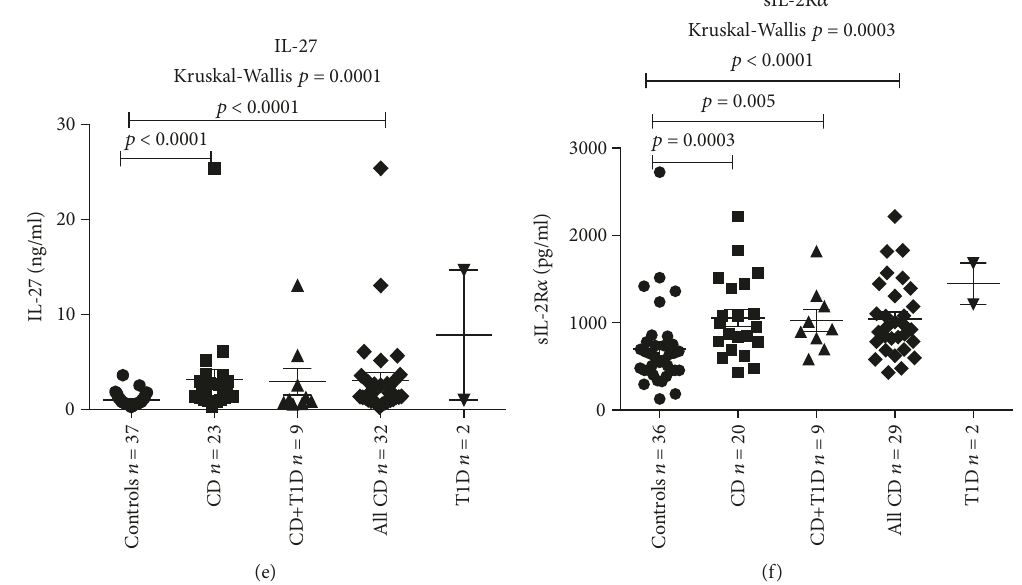
Figure 1: Comparison of serum levels of IL-8 (pg/ml) (a), IL-15 (pg/ml) (b), IL-17F (ng/ml) (c), IL-22 (ng/ml) (d), IL-27 (ng/ml) (e), and sIL-2R α (pg/ml) (f) between di ff erent patient groups (median values and interquartile range). Every dot represents the value of cytokine studied for one person. Median values between the groups were compared using the Mann-Whitney U test. Two T1D persons were excluded from statistical analysis. The outlier in the CD group with an IL-8 value of 207.31 pg/ml (male, 4 years old, with atrophy in small bowel mucosa Marsh grade IIIb, EV density 3+) was excluded from graphic presentation but not from statistical analysis. The outlier in the CD group with an IL-15 level of 229.89 pg/ml, with an IL-17F level of 2.46 ng/ml, with an IL-22 level of 13.46 ng/ml, and with an IL-27 level of 113.37 ng/ml (male, 9 years old, with atrophy in small bowel mucosa Marsh grade II) was excluded from graphic presentation, but not from statistical analysis. The outlier in the control group with a sIL-2Ra value of 5628.53 (male, 1 year old) was excluded from graphic presentation but not from statistical